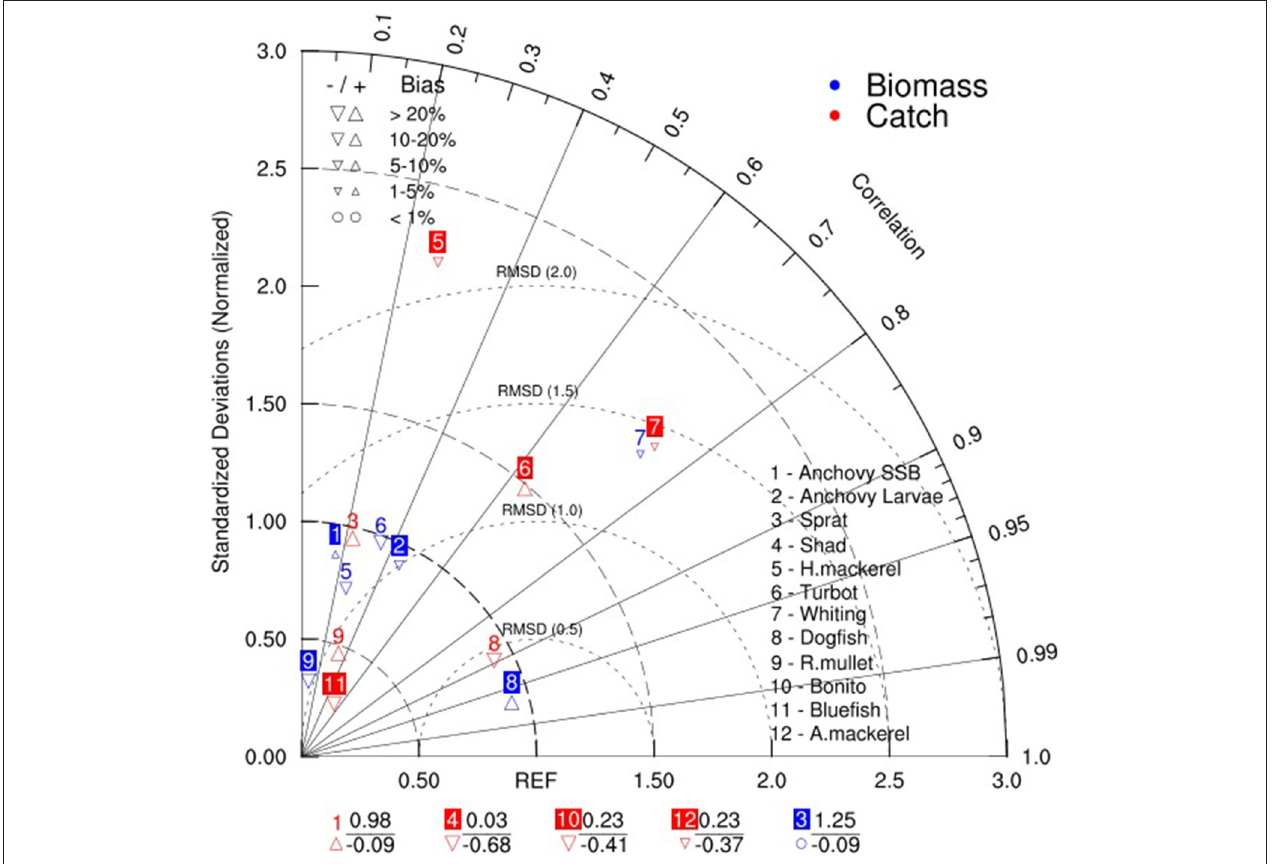
FIGURE 8 | Taylor diagram showing comparison of the higher trophic level model hindcast simulation with data obtained from STECF-15-16 (2015). The angle describes the correlation between model and data, the distance from the origin is the normalized standard deviation and the dashed semi-circles around reference point (REF) on the x-axis define the root mean squared error/distance (RMSD). The labels at the bottom of the figure show summary statistics of groups with negative correlations (below) and their respective normalized standard